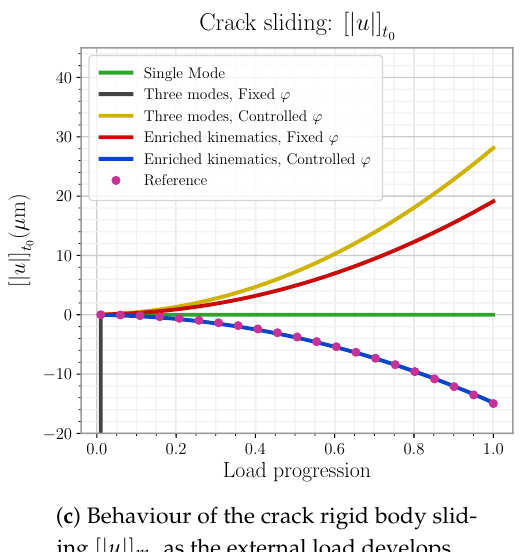
Figure 17. Comparison of the response for fracture rigid body displacements for all five formulations, having ( a ) normal crack separation [ set at zero for both sliding modes.